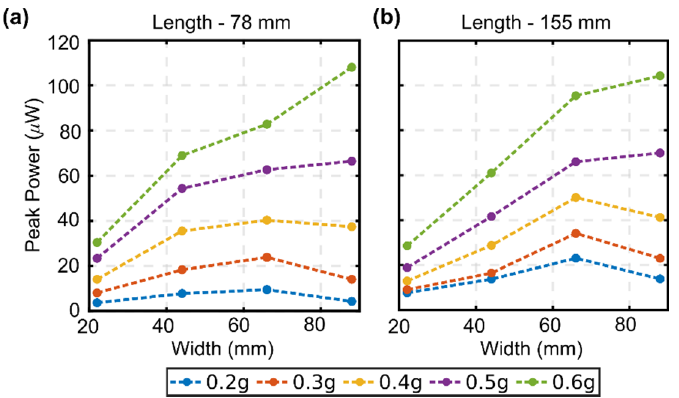
Figure 5. Peak power as a function of harvester width for different base excitation levels; ( a ) set of short harvesters (H1–H4); ( b ) set of long harvesters (H5–H8). Dashed lines are added to help visualize the trends but do not imply a linear variation between measurement points.